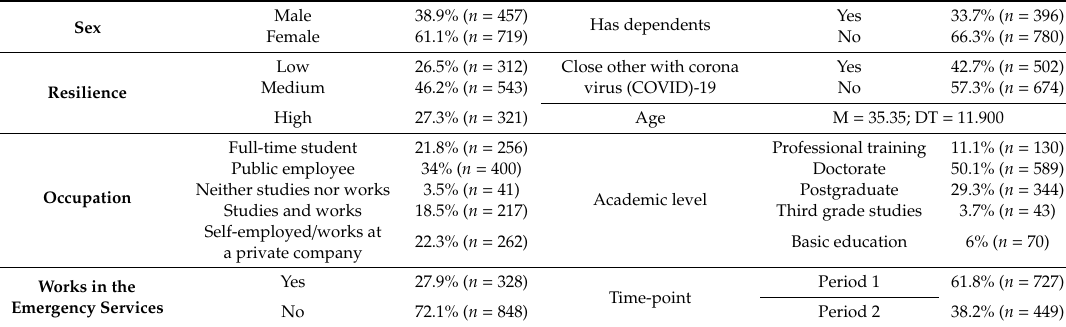
Table 1. Descriptive characteristics of the